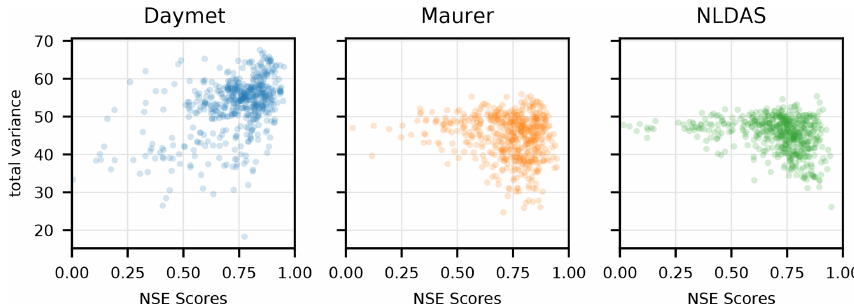
Figure C4. Performance of single-input models relative to the total variance of log precipitation in each basin. The Daymet model tends to perform better in wetter basins (as the total Daymet variance increases), but the other two products have poor-performing basins in catchments with high precipitation variance.